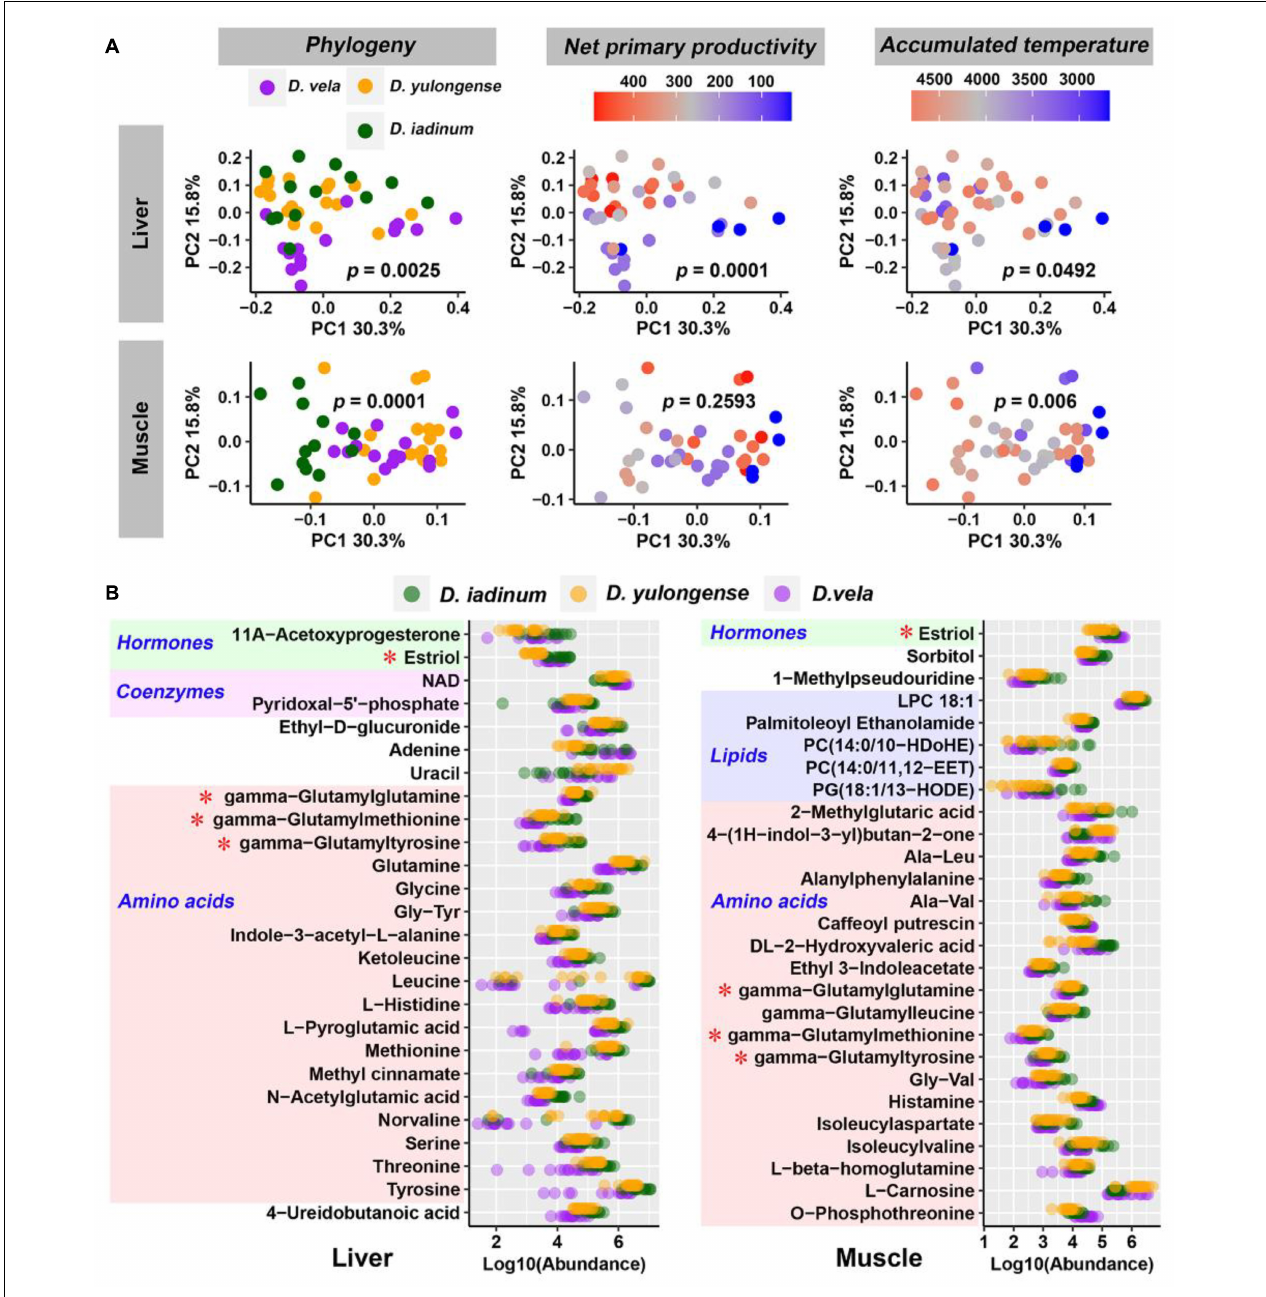
FIGURE 2 | Influences of host phylogeny and climatic factors on the liver and muscle metabolic profiles. (A) PCoA scatter plots presenting the significance of phylogeny and climatic factors on variations in organ metabolome. The p -values of PERMANOVA were labeled. (B) Metabolites varied in abundance between any two Diploderma species ( p < 0.05, Mann–Whitney U -test). Red asterisks denote the metabolites shared by the liver and